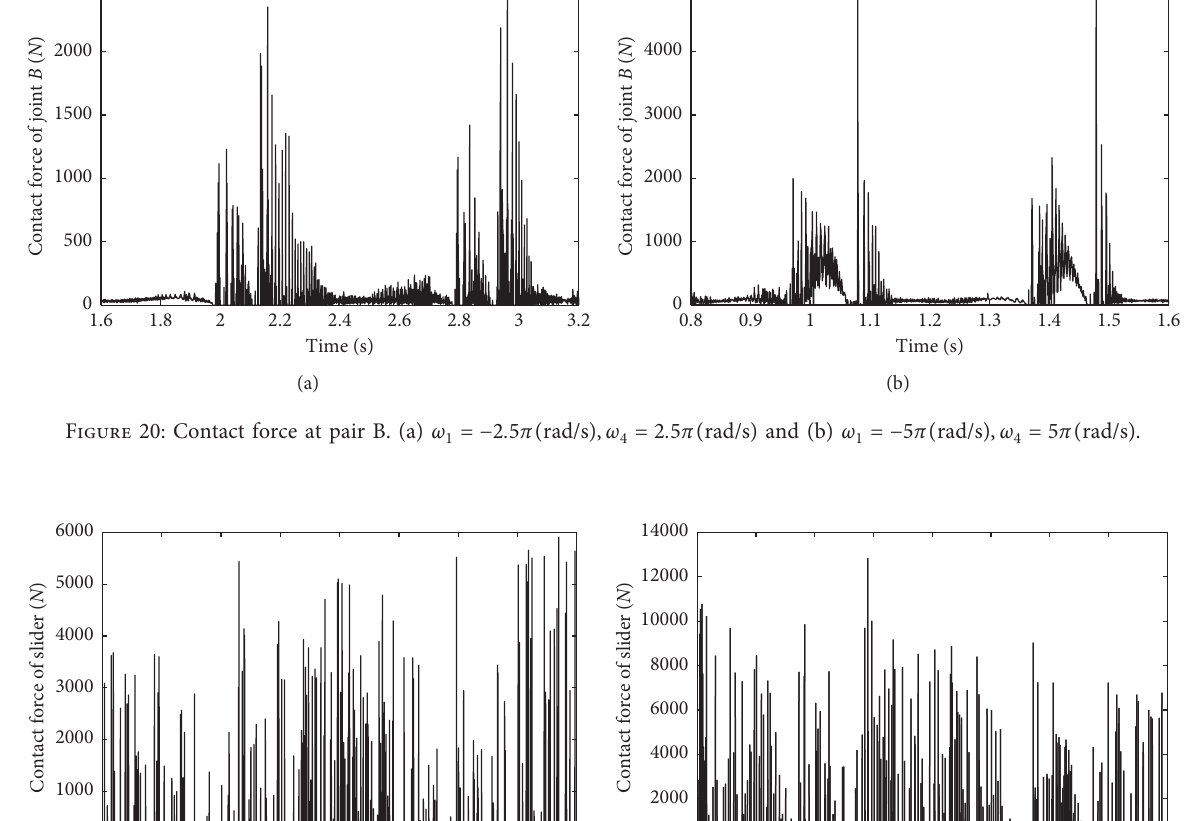
� − 2 . 5 π ( rad/s ) , ω 1